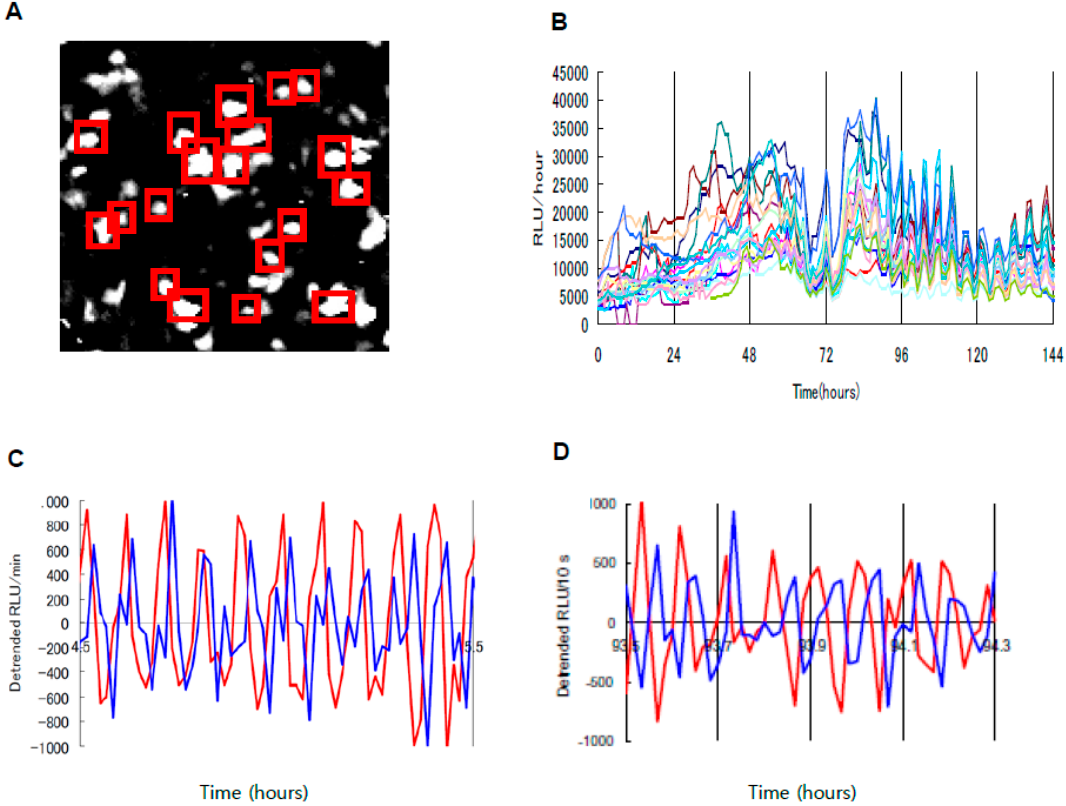
Figure 4. Bioluminescence imaging of ATP, Ca 2+ and oxygen during chondrogenesis. ( A ) Right panel: Bioluminescence imaging at the single-cell level shows that bioluminescent intensities of Actin- Phrixothrix hirtus red luciferase (PxRe) to report intracellular ATP levels in individual cells oscillate collectively by intercellular synchronization during chondrogenesis. Left panel: Time course data of P ACTIN -PxRe intensities of individual cells indicated by red squares after chondrogenic induction. Reproduced with permission from [65]. ( B ) Simultaneous monitoring of intracellular oxygen (blue line) and ATP (red line) levels during chondrogenesis in the micromass culture of mesenchymal stem cells (MSCs) by using an oxygen reporter (P ACTIN -Rluc) and ATP reporter (P ACTIN -PxRe). Reproduced with permission from [65]. ( C ) Simultaneous monitoring of intracellular Ca 2+ (blue line) and ATP (red line) levels during chondrogenesis in micromass culture of ATDC5 cells using a calcium reporter (aequorin) and ATP reporter (P ACTIN -PxRe). Reproduced with permission from [67]. Similarly, by using a blue-emitting aequorin and a red-emitting PxRe luciferase, intracellular Ca 2+ and ATP levels were simultaneously monitored during chondrogenesis [67]. The results showed